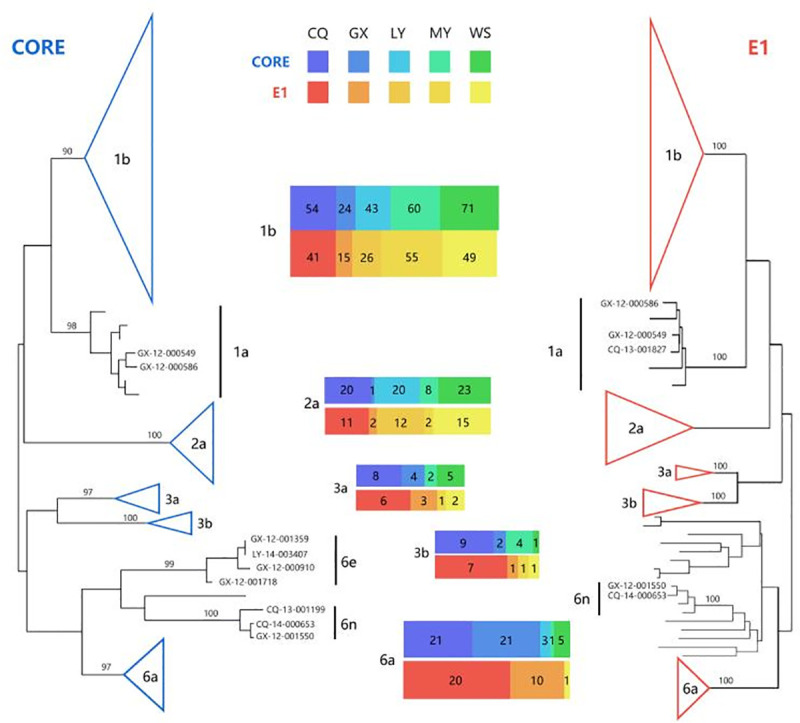
Phylogenetic tree constructed using HCV Core and E1 gene sequences from blood donors in China.Phylogenetic analysis was performed using the neighbor-joining and the Kimura two-parameter method to get the accurate HCV genotyping, and the node supports were evaluated with 1000 bootstrap replicates. The colored triangles and vertical lines represent different HCV subtypes. The upper bar refers to the Core region and the lower bar refers to the E1 region. The colored rectangular area represents the number of HCV subtypes in five regions including Chongqing (CQ), Guangxi (GX), Luoyang (LY), Mianyang (MY) and Urumqi (WS).